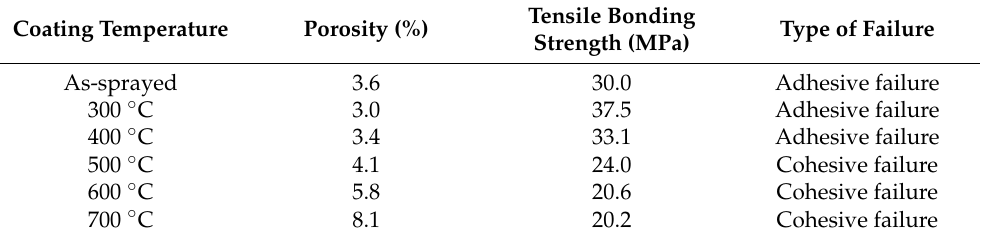
Table 2. Coating properties.